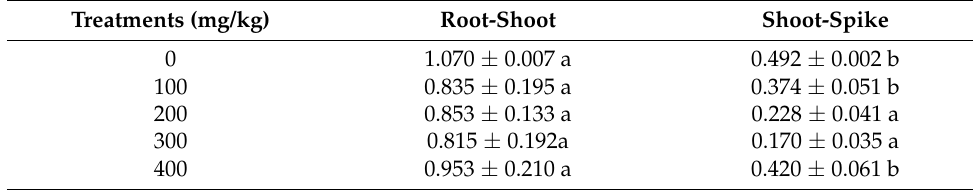
Table 3. Zn transport coefficients of all parts of sea